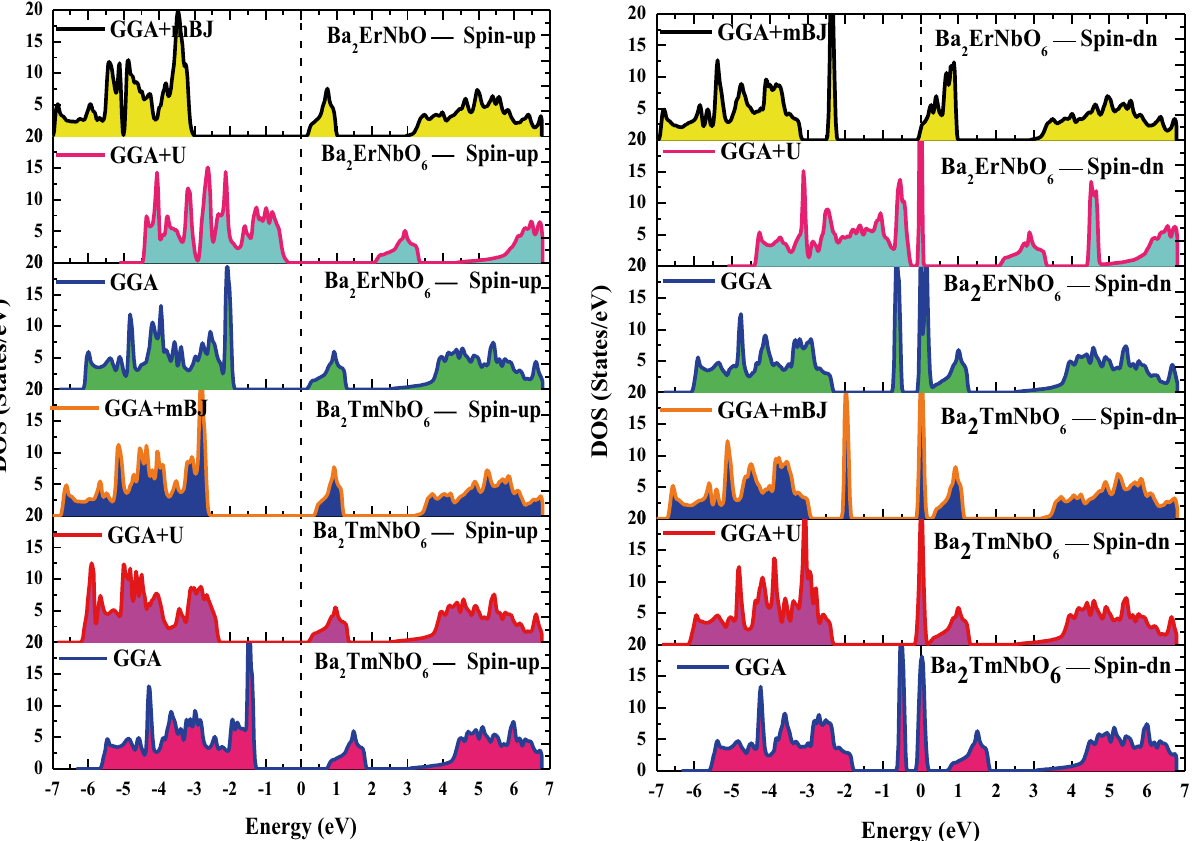
Figure 5. Spin polarised total density of states (DOS) in GGA, GGA + U and GGA + mBJ for Ba 2 ErNbO 6 and Ba 2 TmNbO 6